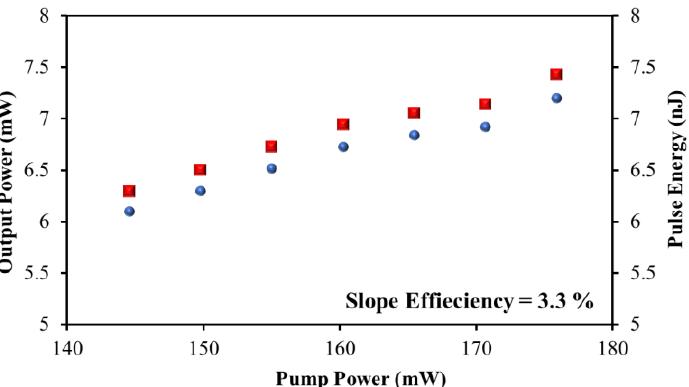
Figure 10. Output power and pulse energy of mode-locked MAX within 144.57 to 175.87 mW.